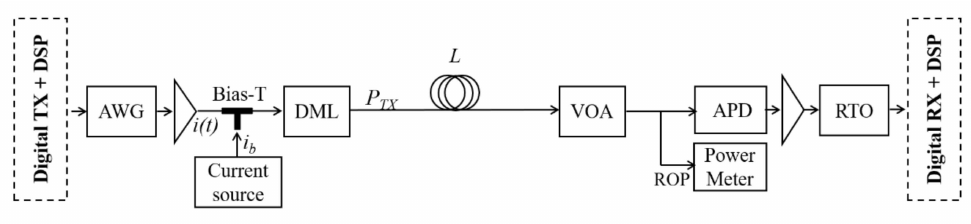
Figure 1. Experimental